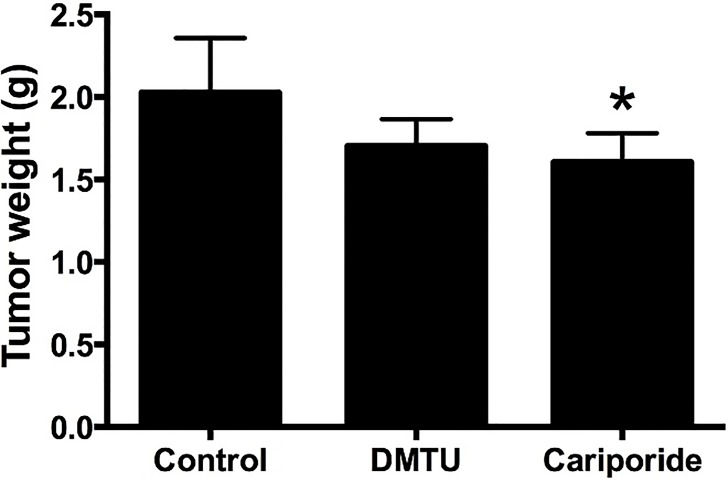
Cariporide-mediated suppression of tumor growth in the nude mice bearing human OS xenografts. Data represent mean ± SD of N = 6.*P < 0.05 versus control.